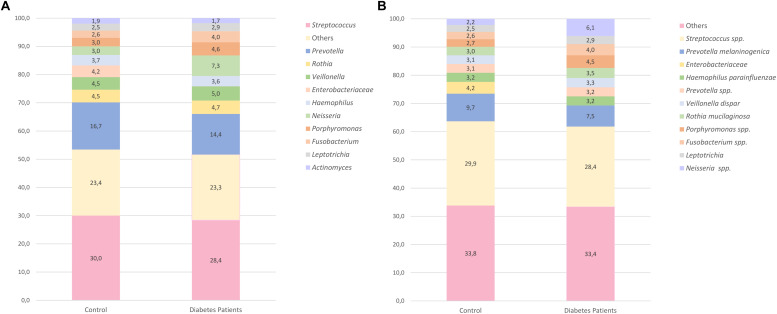
Relative abundance of the 10 most-abundant taxa found at the genus level (A) and at the species level (B) in both control and diabetes groups. The remaining taxa are included in the category “Others”.